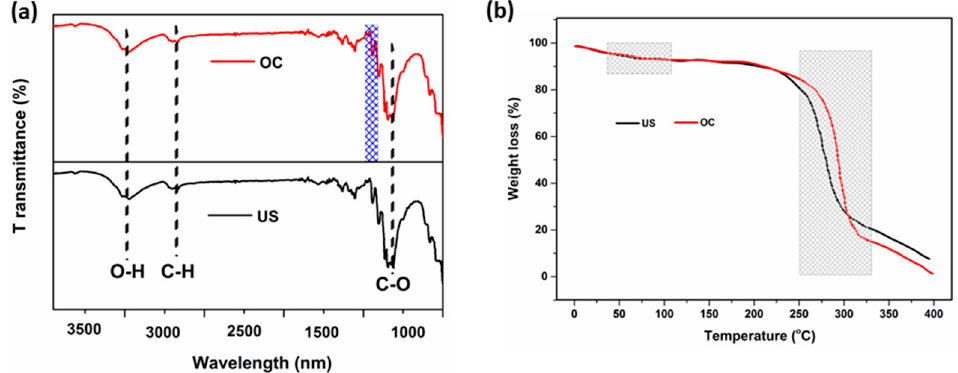
Figure 9. ( a ) FTIR and ( b ) TGA (in nitrogen) spectra of the untreated sample (US) and optimized condition (OC) sample.